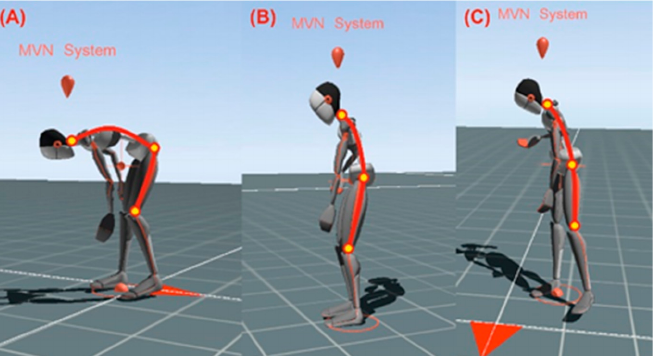
Figure 2. Avatar CoM display from MVN Analyzer Pro for three methods of starting the chainsaw (the orange dot shows the position of the subject’s CoM); (( A ) from the ground method, ( B ) between the knees method, ( C ) “drop starting” method).